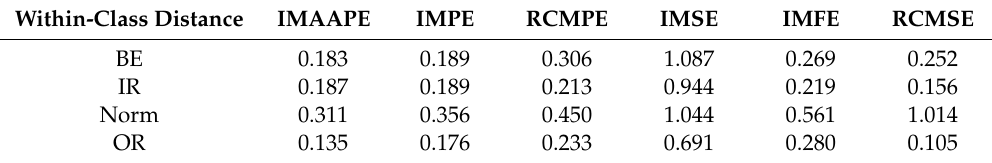
Table 4. The within-class distance of di ff erent rolling bearing fault feature extraction methods.